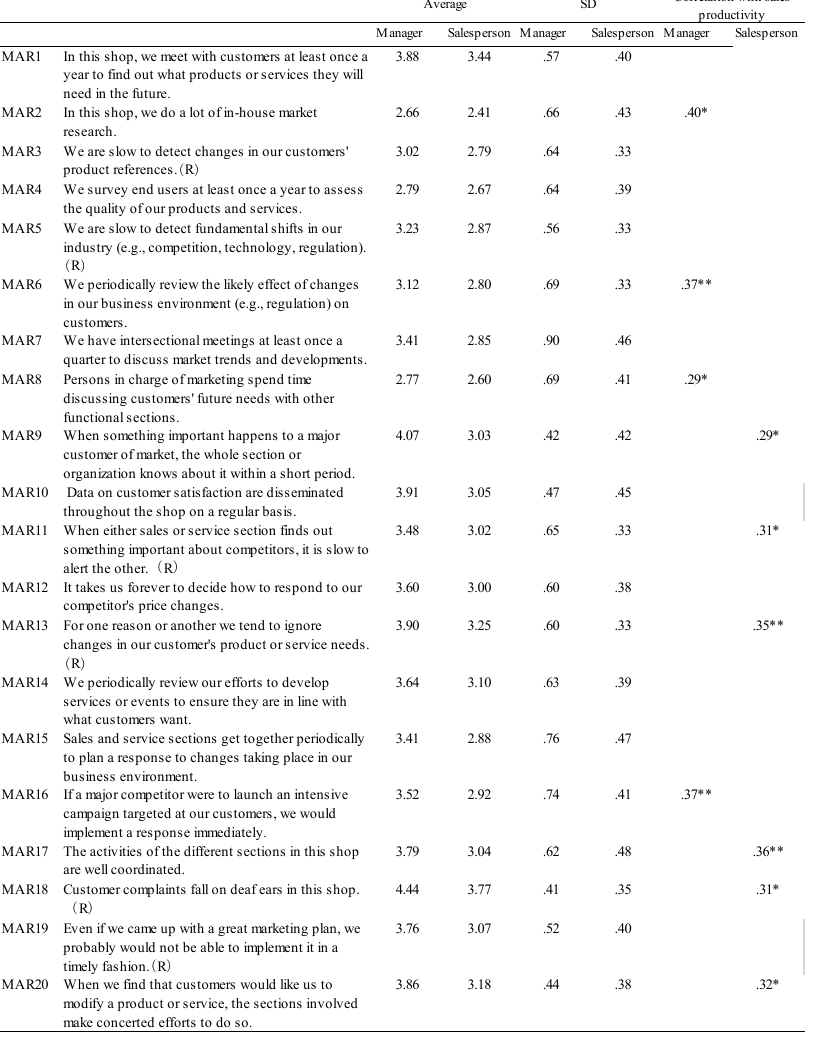
Correlation with sales